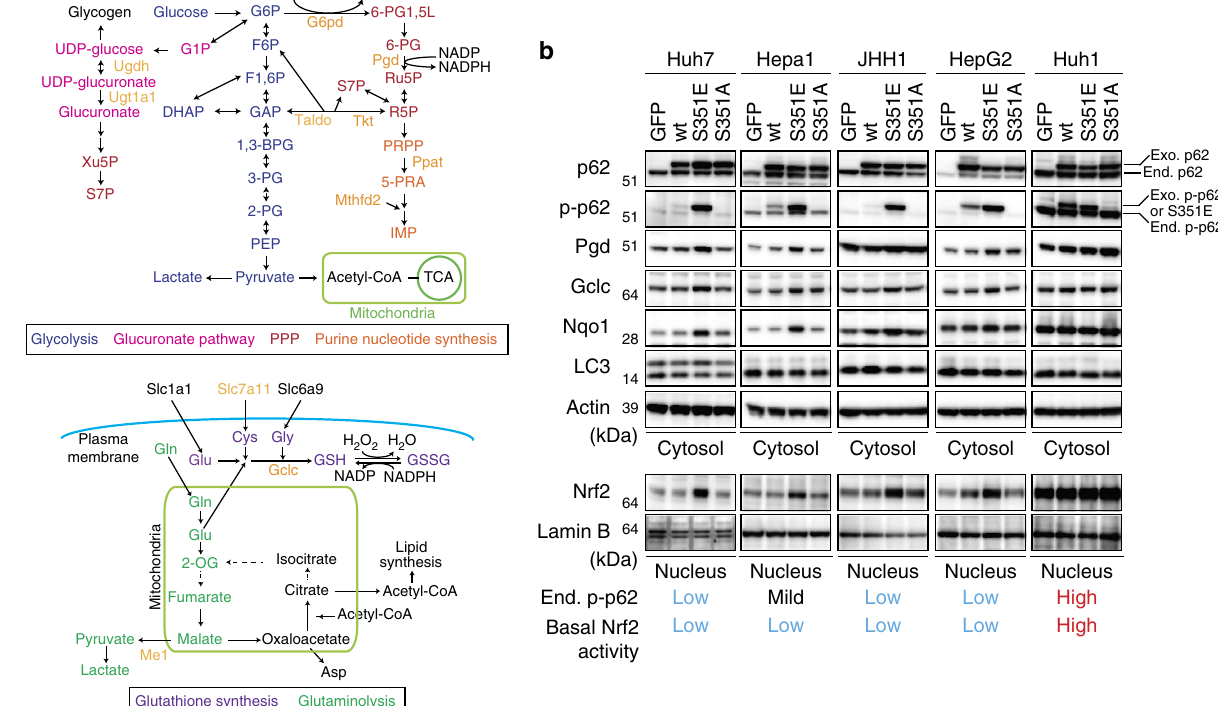
Figure 1 | Activation of Nrf2 in HCC cells expressing phospho-mimetic p62. ( a ) Enzymes involved in glucose and glutamine metabolism regulated by Nrf2. ( b ) Immunoblot analysis. FLAG-tagged p62 and its mutants were overproduced in the indicated HCC cells using an adenovirus vector. At 48h after infection, cytosolic and nuclear fractions were prepared and subjected to immunoblot analysis with the specified antibodies. Data were obtained from three independent experiments.